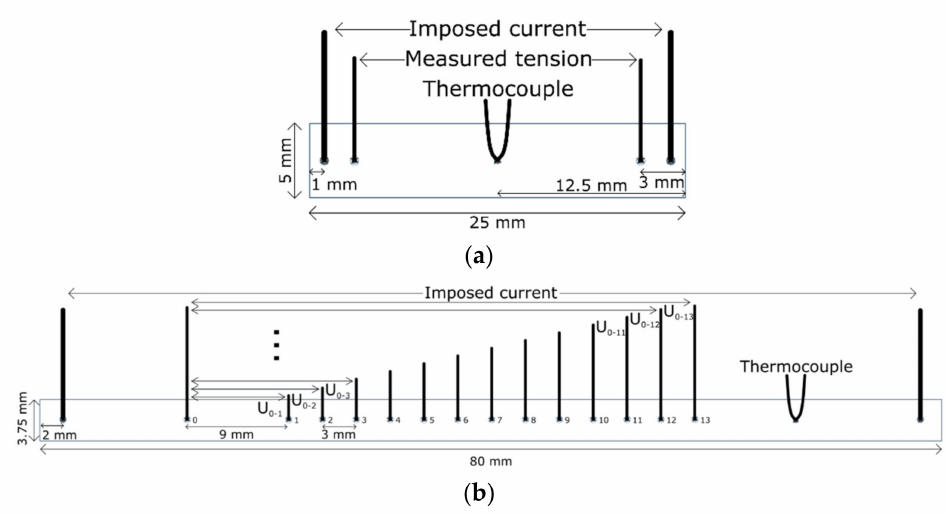
Figure 1. Electrical resistivity measurement specimen instrumentation: ( a ) classical four-point method and ( b ) multi-point